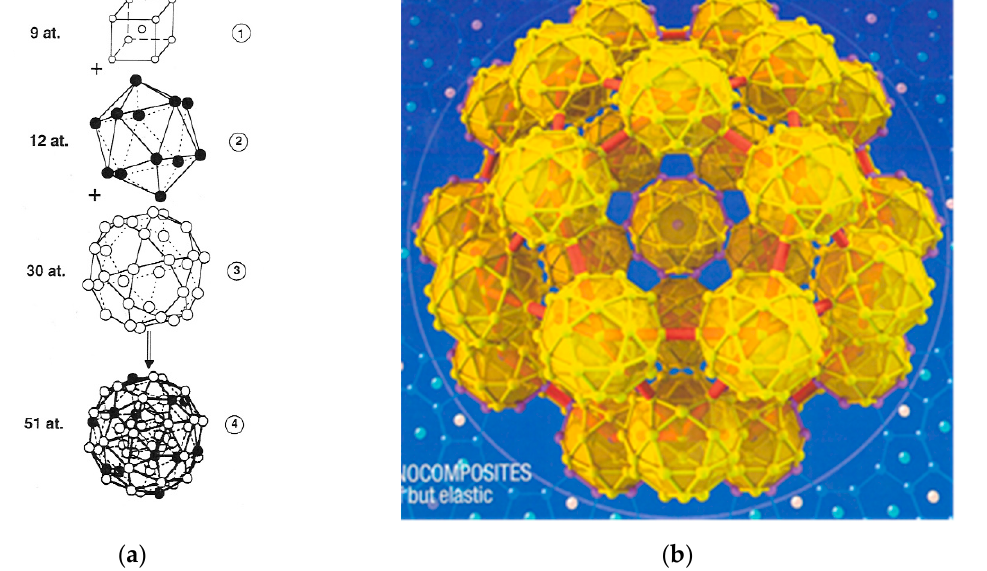
Figure 8. ( a ) Structure of a pseudo-Mackay cluster containing an inner cubic shell (1), followed by an icosahedron shell (2), and an icosidodecahedron (3) shell. The number of atoms in each shell is indicated in the figure. White (black) circles denote Al (TM) atoms, respectively. (Reprinted figure with permission from Janot, C. Conductivity in quasicrystals via hierarchically variable-range hopping. Phys. Rev. B 1996 , 53 , 181. Copyright (1996) by the American Physical Society); ( b ) A three-dimensional perspective of the τ ³-inflated cluster forming the basic icosidodecahedron structural motif of i-CdYb phase. Its radius is about 12 nm. (Reprinted by permission from Springer Nature: Nature Materials, Takakura, H.; Pay-Gómez, C.; Yamamoto, A.; de Boissieu, M.; Tsai, A. P. Atomic structure of the binary icosahedral Yb-Cd quasicrystal. 2007 , 6 , 58-63, Copyright (2007)).